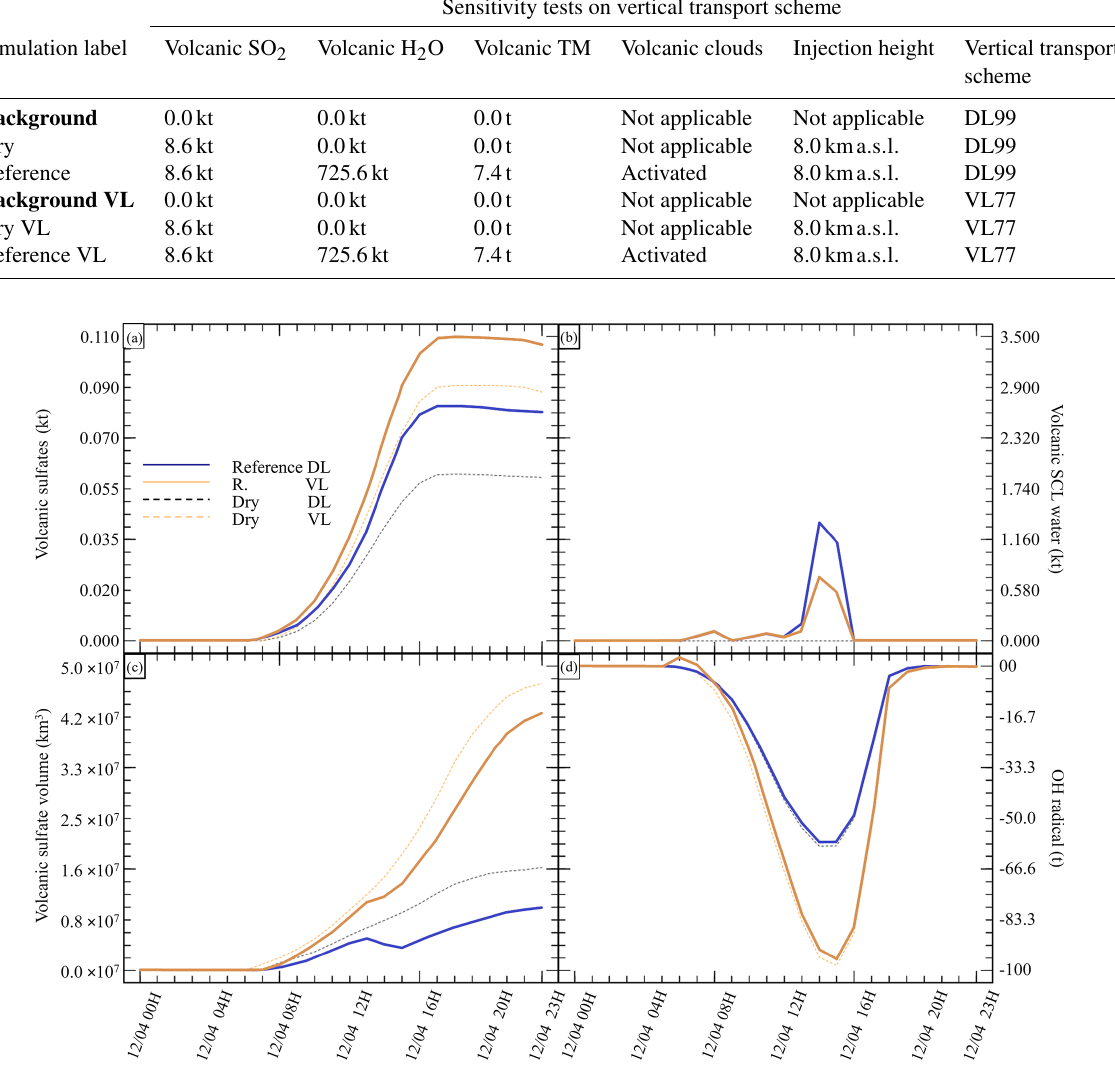
− , kt), (b) supercooled liquid water (kt), (c) the minimum volume 4(p)